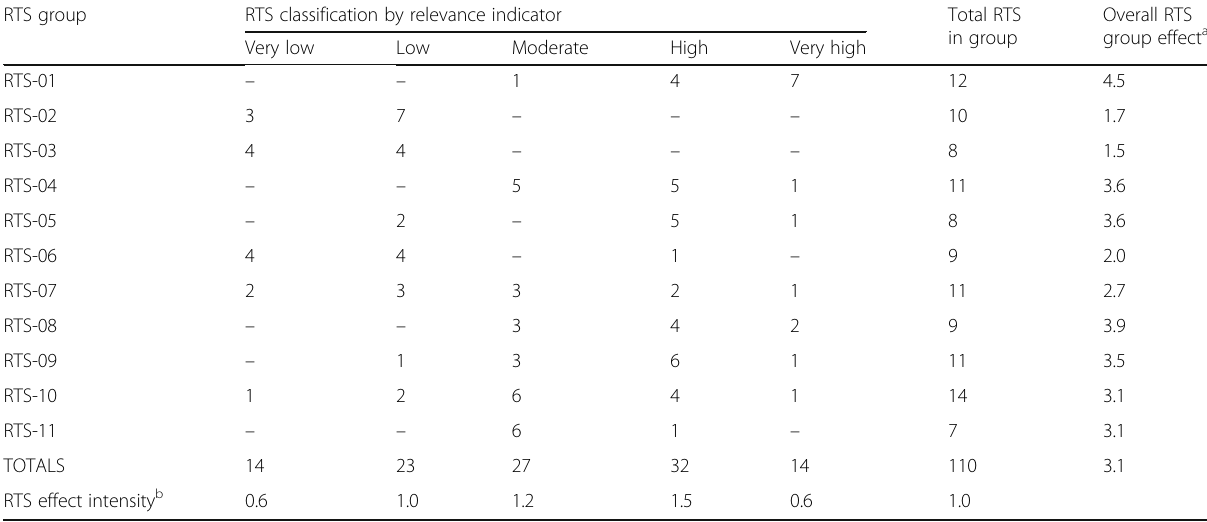
Table 2 Assessment of the RTS groups regarding their bioeconomy relevance RTS group RTS classification by relevance